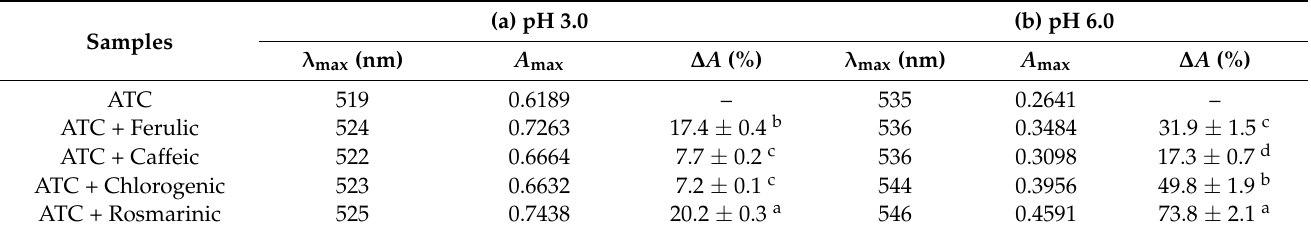
Table 1. Effect of intermolecular copigmentation on the maximum absorption wavelength ( λ max ) and maximum absorbance ( A max ) of anthocyanin solutions of DBP extracts with phenolic acids as copigments at Day 0 (copigment:anthocyanin molar ratio of